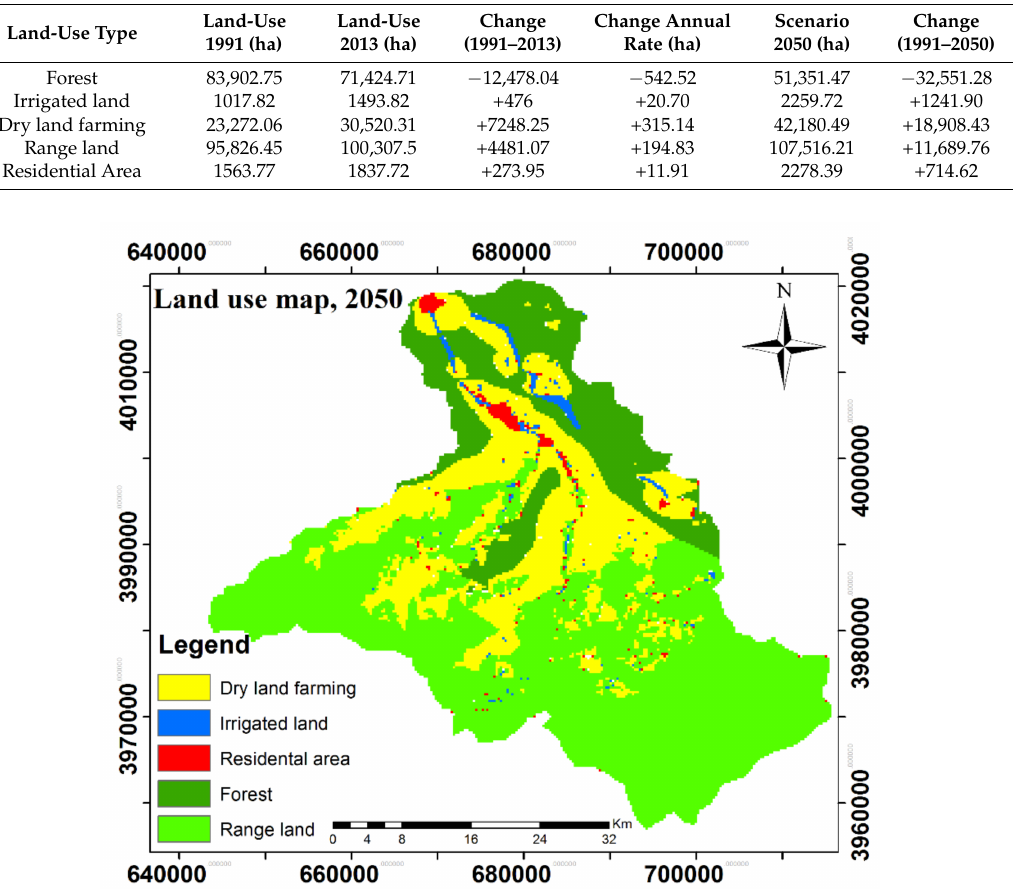
Figure 5. Land-use scenario in